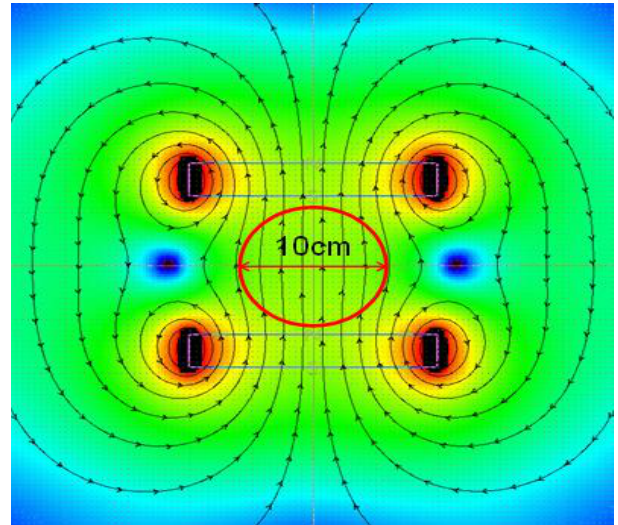
Figure 1. Distribution of the permanent magnetic field, induction of B = 100 mT, within the sample subjected to extraction.